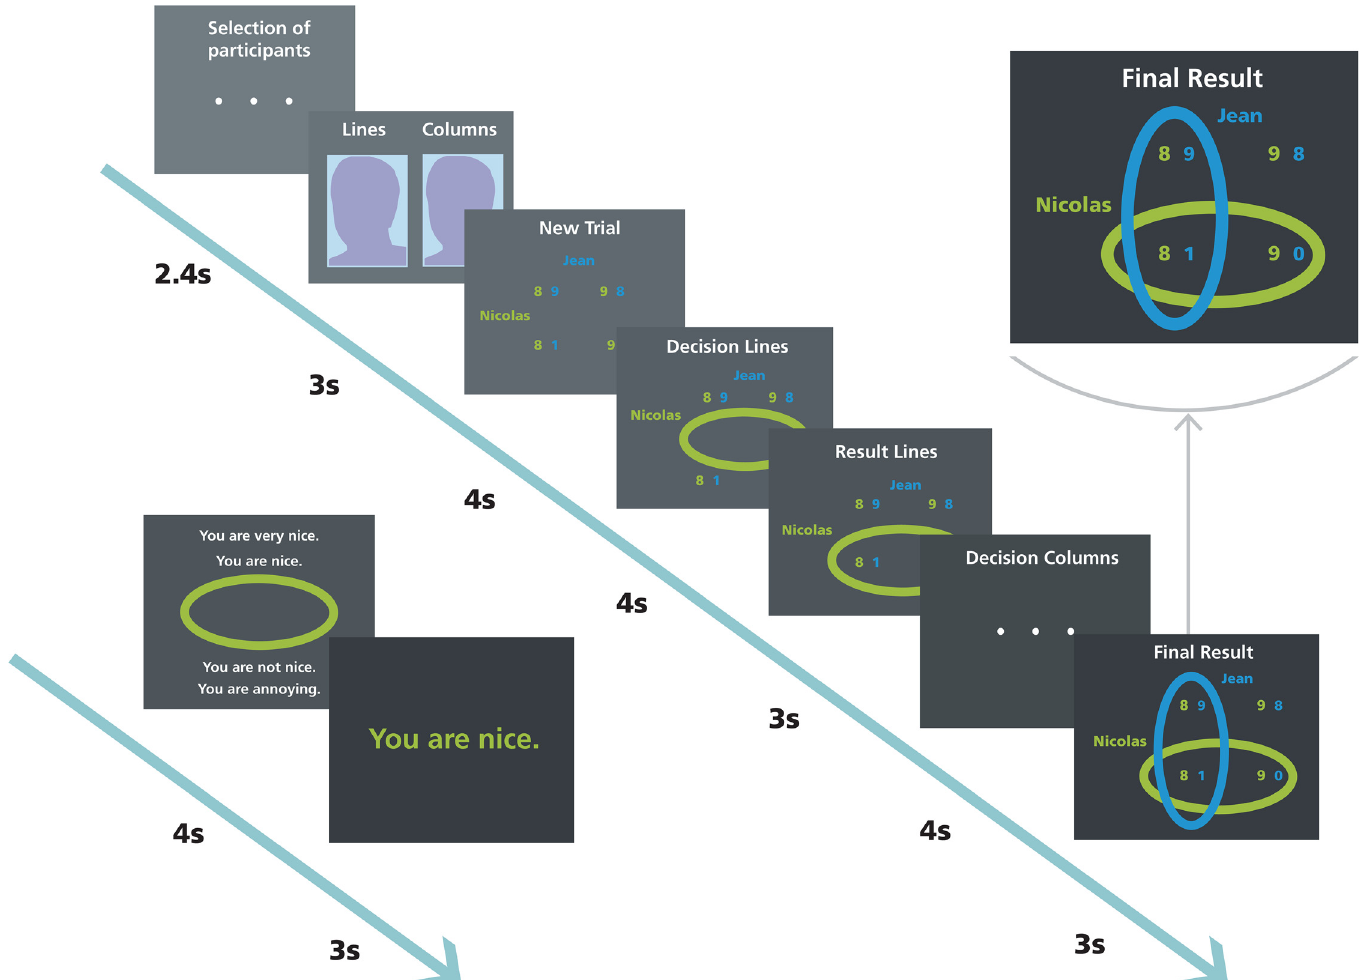
Fig 1. Trial timeline of the Inequality Game, depicted for the high power phase. After player selection, the photographs of both paired players were presented, along with their assignment to control the lines (high power) or the columns (low power). The payoff structure of a new trial was shown for 4 s. The participant (here Nicolas, in green) then chose one of the two lines. After displaying the participant ’ s choice, the ostensible other (here Jean, in blue) made a decision. The common choice (Final Result) determined the payoff (here: 8 CHF for Nicolas and 1 CHF for Jean). Half of the economic interactions were followed by feedback trials. Here, the player with high power (green) had the opportunity to select between one of four feedback choices for the other, which were subsequently displayed. In the low power phase, the participant was in control of the columns (blue).